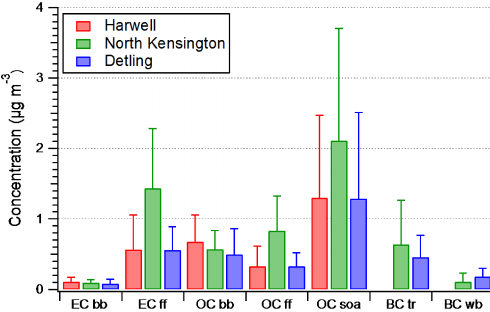
Figure 4. Average of daily concentrations of EC bb , EC ff , OC bb , OC ff and OC SOA apportioned using the tracer method (Gelencsér et al., 2007). Variability shown is 1 standard deviation. Table 3. Average of daily percentage fractions of non-fossil and fossil TC for the tracer and 14 C methods. Variability shown is 1 standard deviation. *Denotes the averages for the sampling days with both 14 C and EC / OC